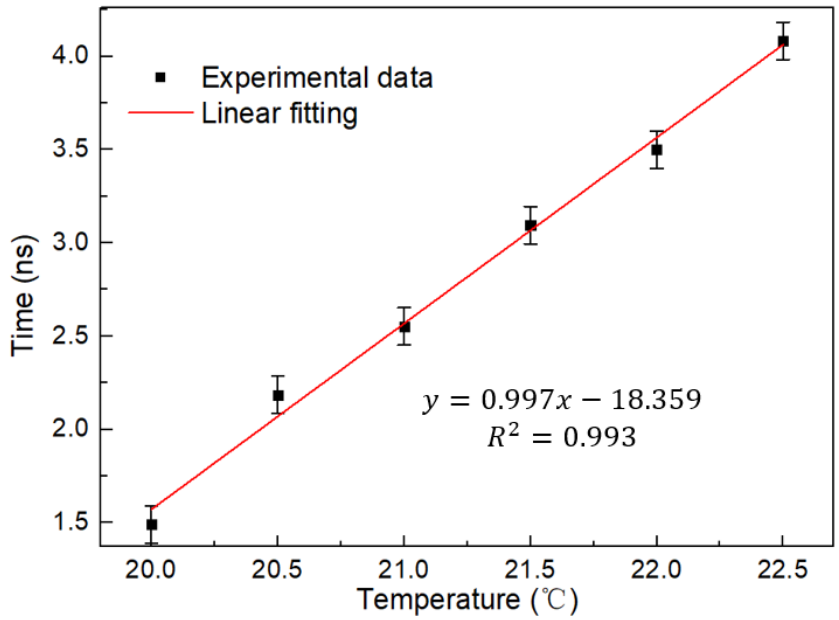
Figure 11. Linear fitting curve of temporal waveform and temperature ofa a single Saganc ring at 20–22.5 °C . 20–22.5 ◦